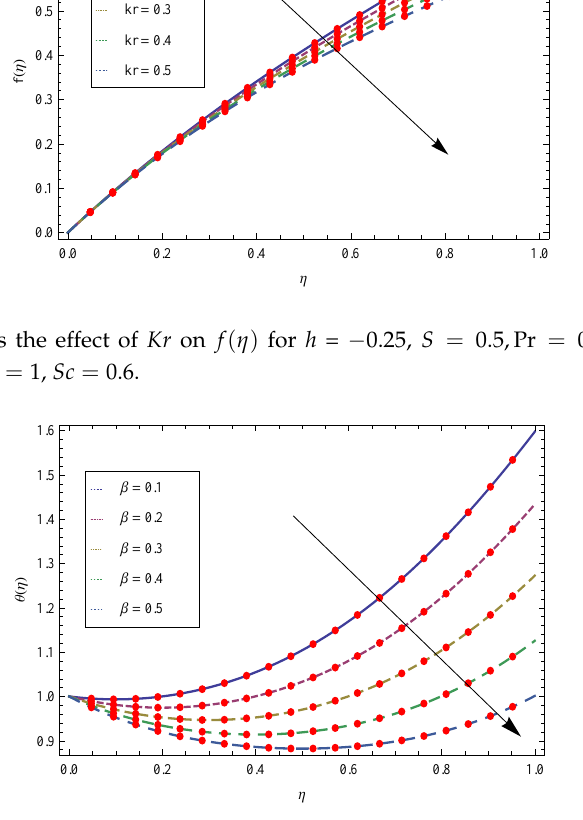
Figure 11. Shows the effect of β on θ ( η ) for h = − 0.7, λ = 1, S = 0.5,kr = 0.5,Pr = 0.5,Ec = 0.5, Nb = 0.5,Nt = 0.6, and Sc =